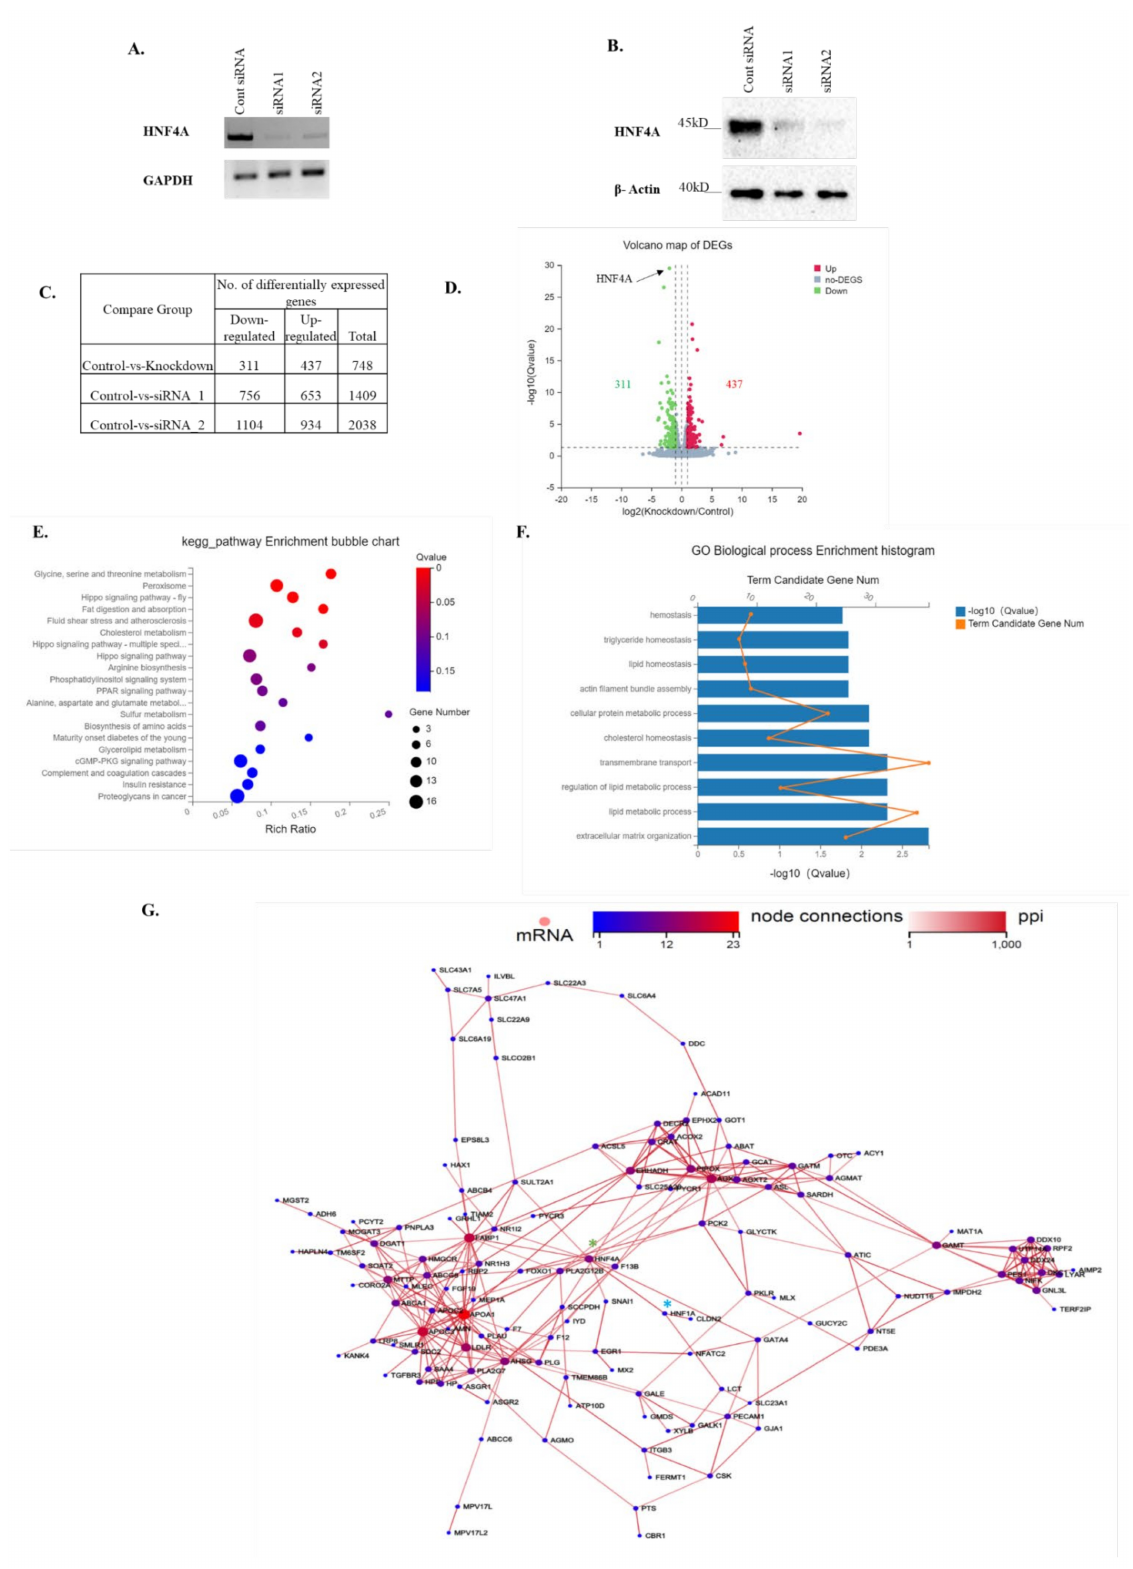
Figure 4. HuH7 cells were transfected with 20 nM concentrations of either control siRNA (SIC; MISSION®siRNA Universal Negative Control #1) or HNF4A-specific siRNAs. ( A ) The KD